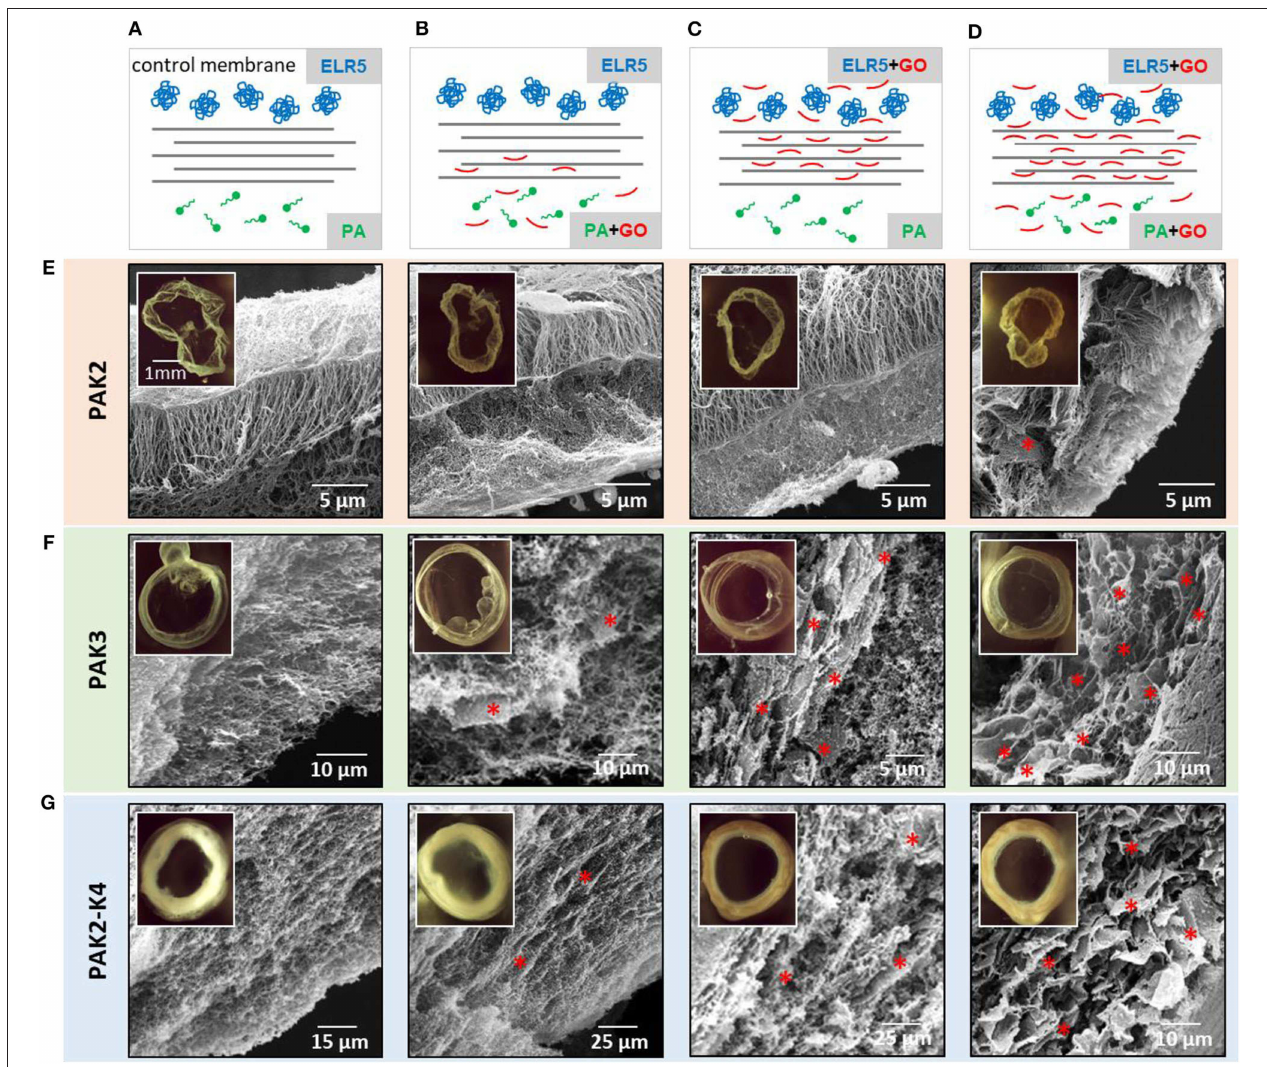
FIGURE 3 | Investigation of GO incorporation in different ELR5/PA systems. First row illustrates the different experimental setups including (A) co-assembly of ELR5 and PAs (controls), (B) GO combined with PAs before membrane formation, (C) GO combined with ELR5 before membrane formation, and (D) GO combined with both PAs and ELR5 before membrane formation. Rows (E,F,G) depict SEM micrographs of cross-sections of the different systems including ELR5/PAK2 (row E ), ELR5/PAK3 (row F ), and ELR5/PAK2-K4 (row G ). Asterisks * point to GO flakes. Insets are top view bright field images of the corresponding tubes. Differences in color/contrast of the inset images are a result of differences in the structure of the generated